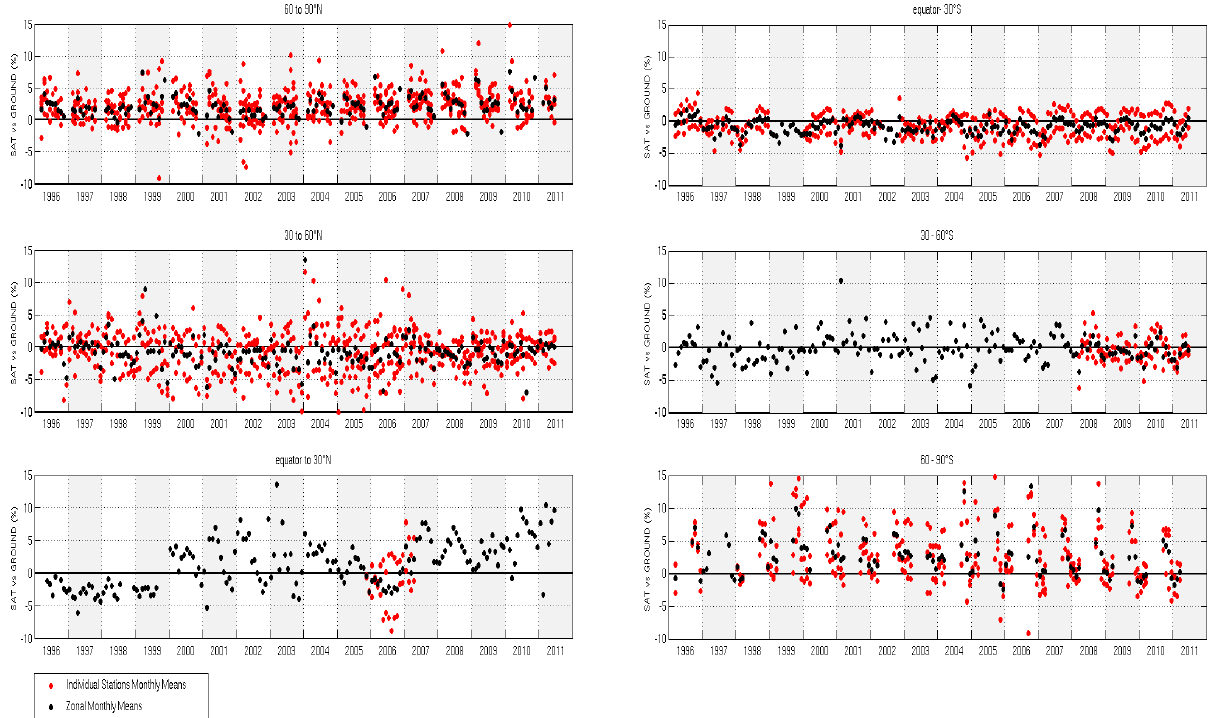
Figure 13. Time series of monthly mean relative differences for NDACC UV–visible instruments for six 30 ◦ latitude zones; Northern Hemisphere in the left panels (from top to bottom: high, middle, and low latitudes), and Southern Hemisphere in the right panels (from top to bottom: low, middle, and high latitudes). Red dots correspond to individual stations, black dots correspond to the zonal means. If only one station contributes, the single-station differences are coincident with the zonal